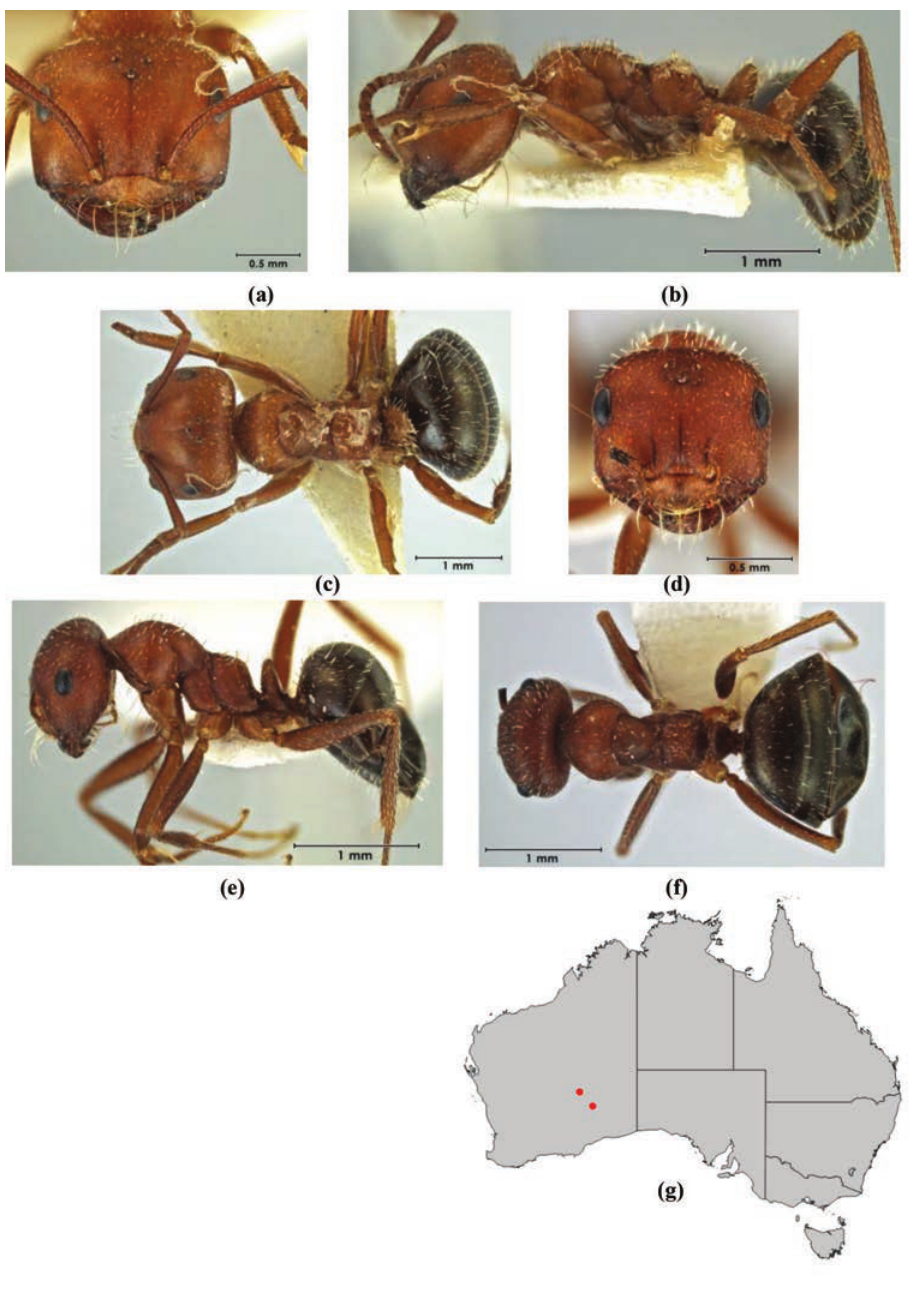
Figure 71. Melophorus solitudinis sp. n.: major worker paratype (ANIC32-066647–bottom ant) frons ( a ), profile ( b ) and dorsum ( c ); minor worker holotype (JDM32-004513) frons ( d ), profile ( e ) and dor- sum ( f ); distribution map for the species ( g